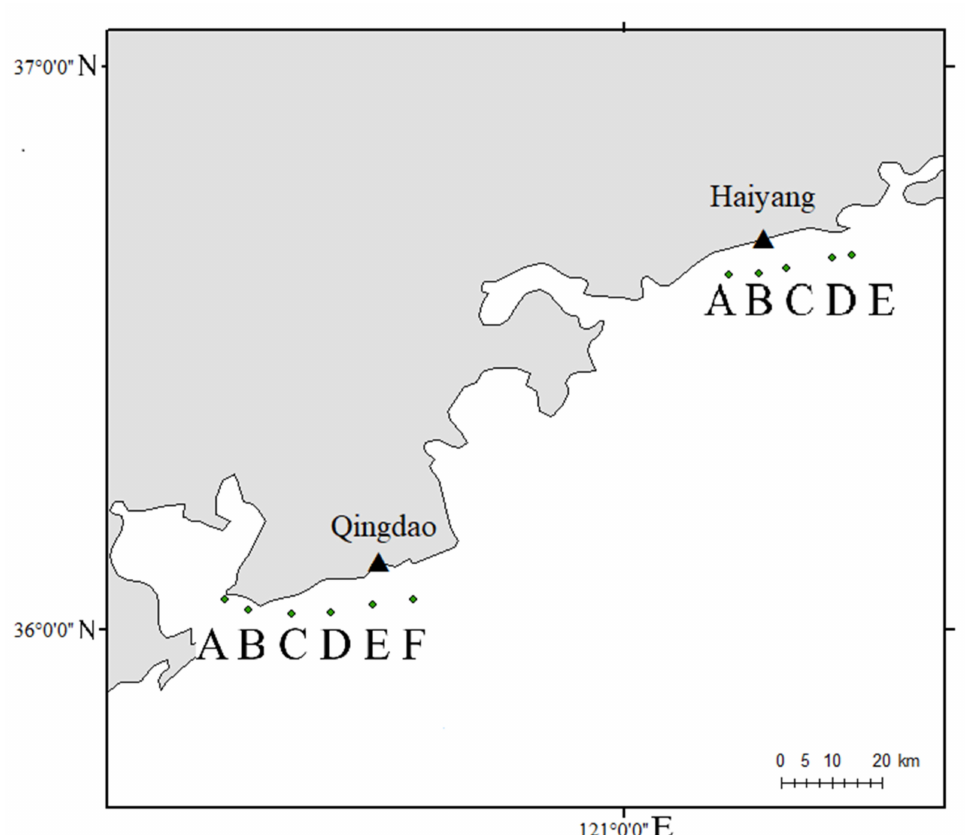
Figure 1. Sampling location distribution in the Qingdao sea area and Haiyang sea area of the South coast of the Shandong Peninsula. ABCDEF indicate each location respectively in the Qingdao sea area and Haiyang sea